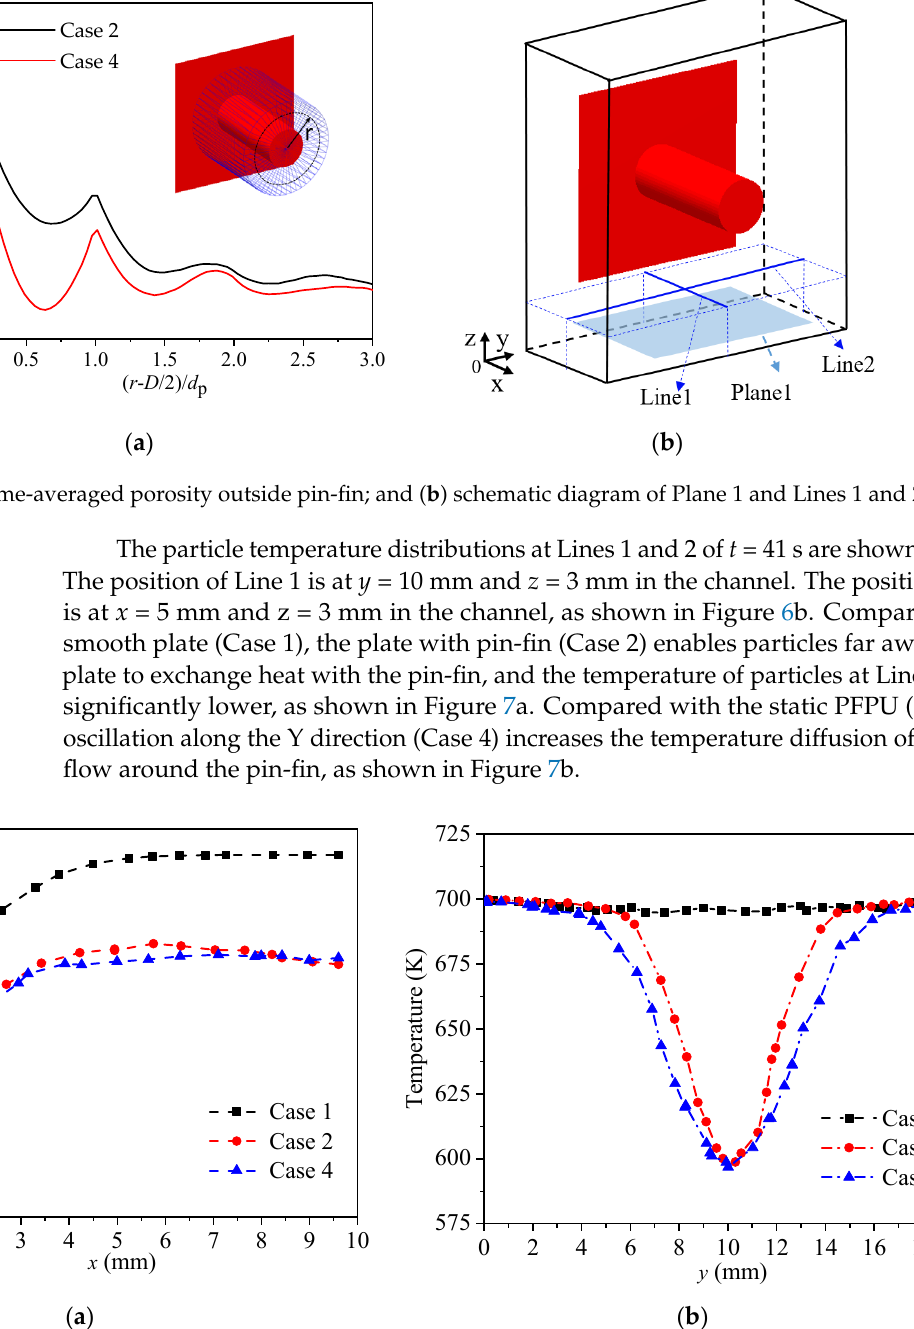
is significantly lower, as shown in Figure 7a. Compared with the static PFPU (Case 2), the flow around the pin-fin, as shown in Figure 7b.